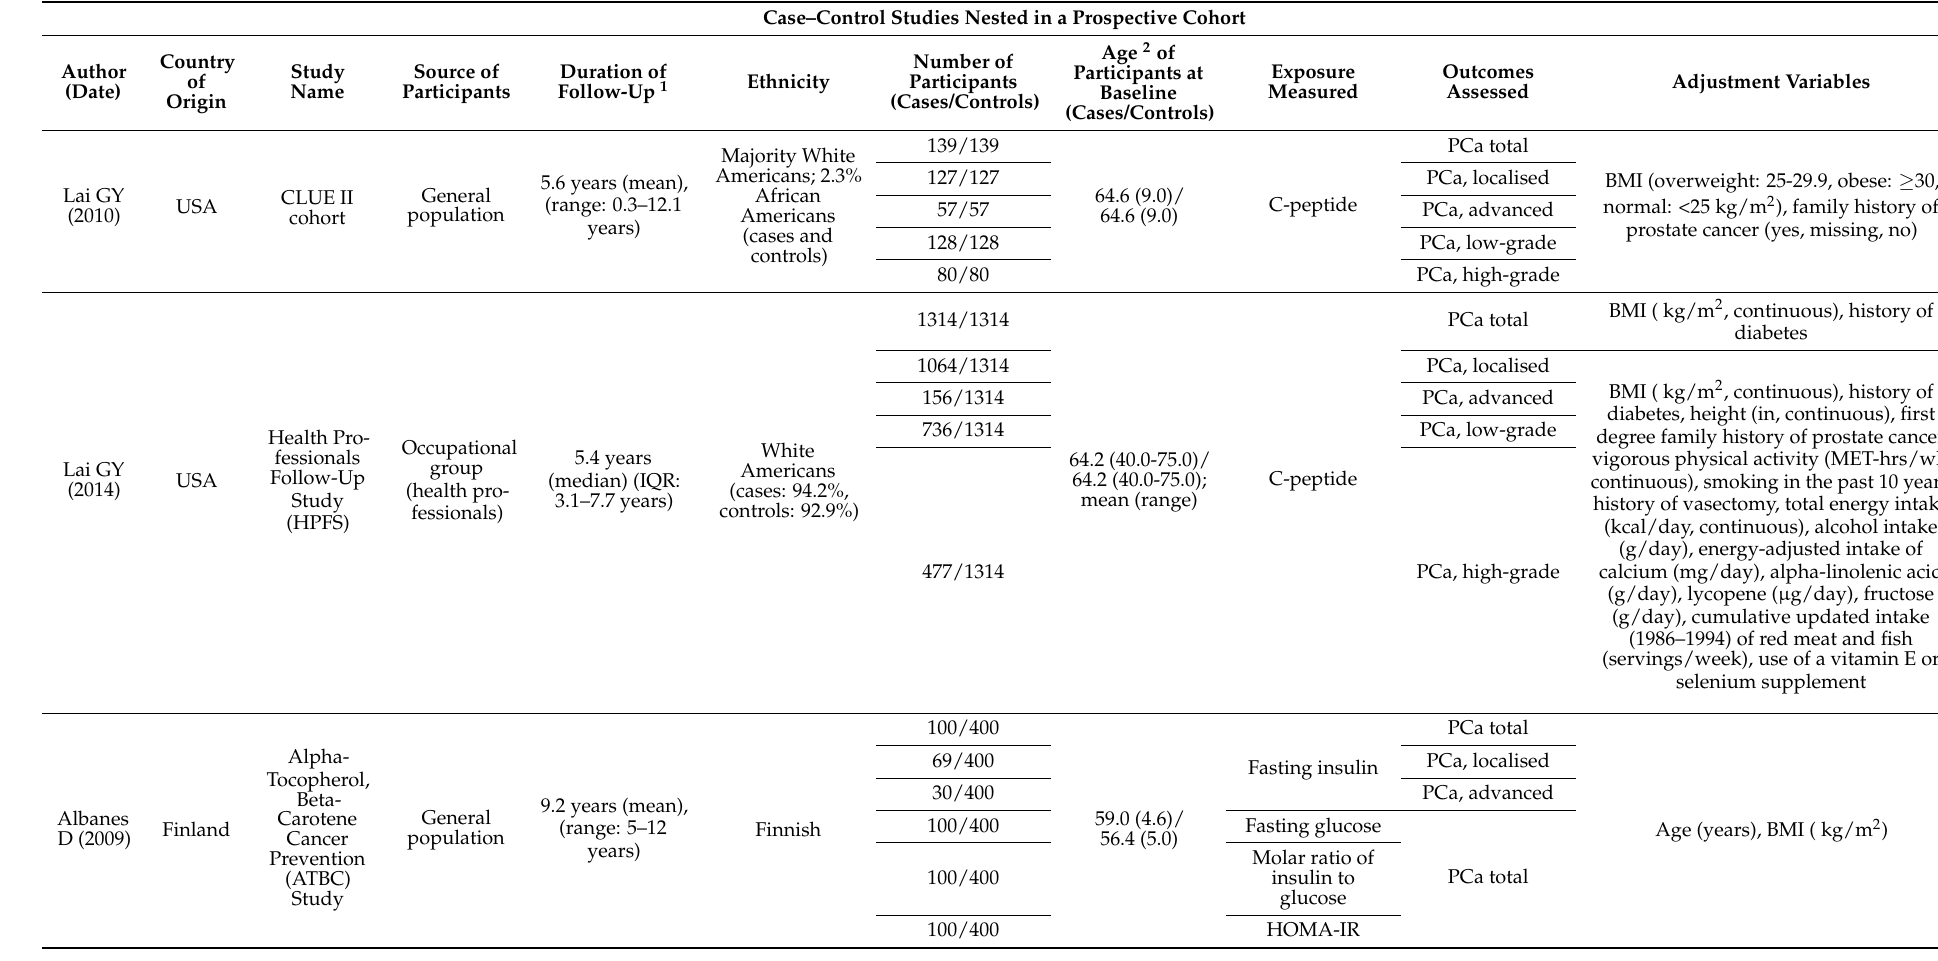
Table 2. Characteristics of included studies (insulin–PCa association set of